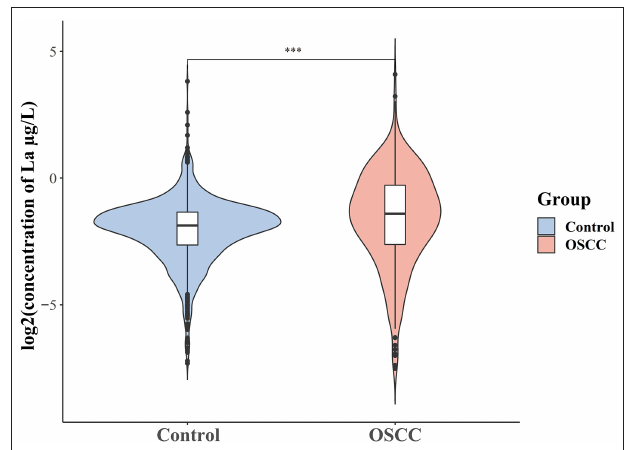
FIGURE 1 | Distribution of serum La in case and control1 groups, for visualization purposes, we log 2 transformed the measured la concentrations. *** P < 0.001 by Wilcoxon rank sum